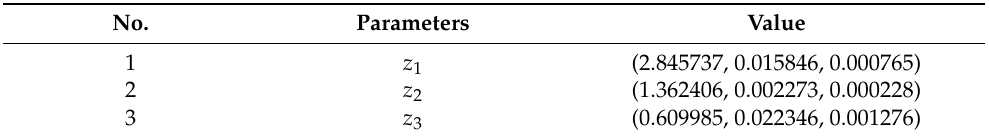
Table 2. Parameter learning